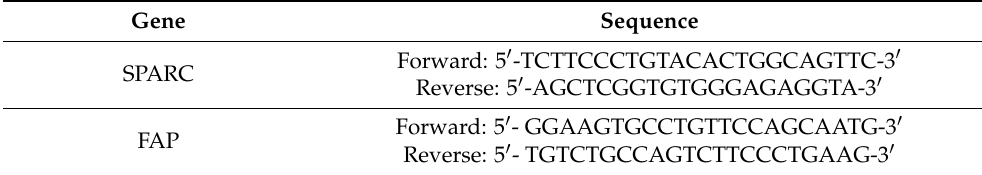
Table 2. Sequence of oligonucleotides used in qRT-PCR